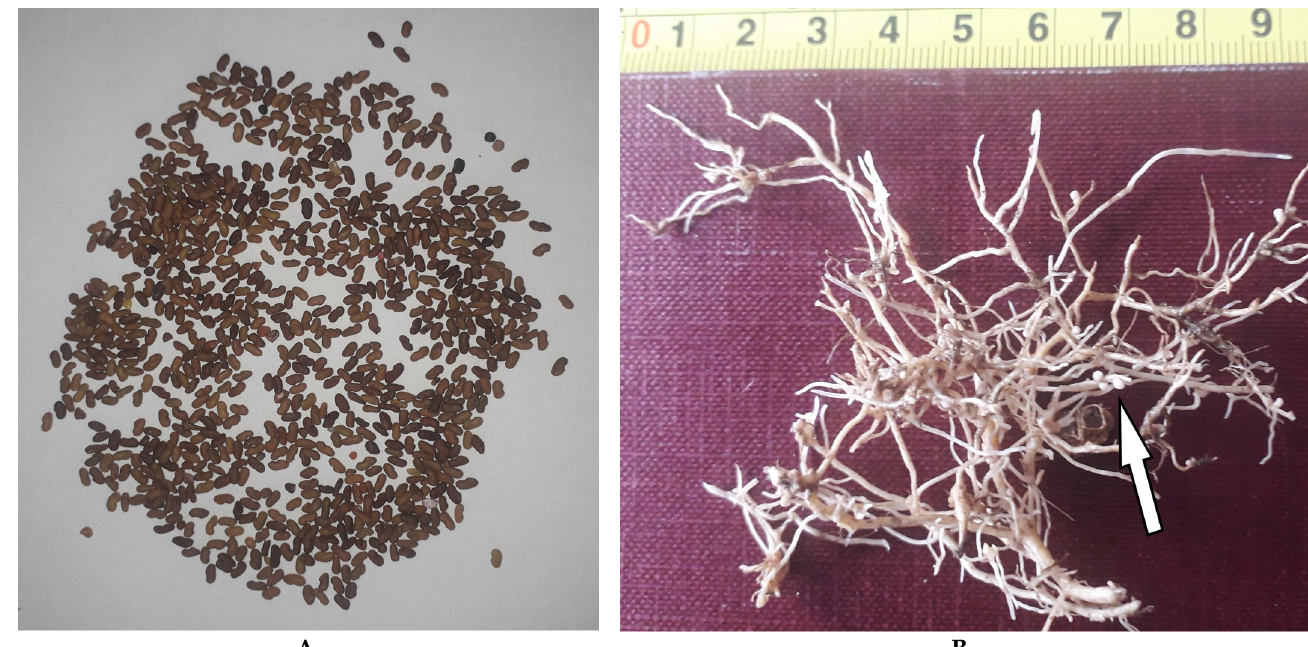
Figure 3. Fodder galega: ( A ) seeds; and ( B ) root nodules ( Ż arczy ń ski 2021).